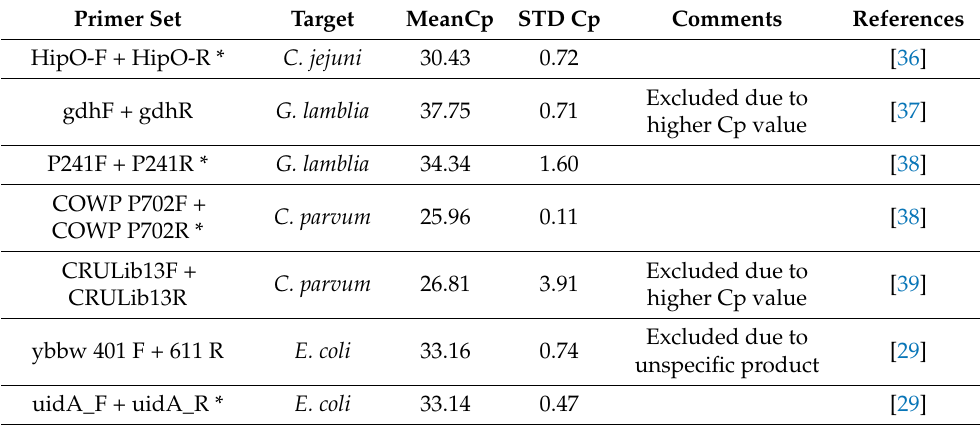
Table 1. Evaluation of the efficiency of primer sets targeting C. jejuni , G. lamblia , C. parvum , and E. coli at 500 nm final primer concentration. Lower MeanCp suggests better amplification efficiency. *—Primer sets selected for further optimisation.